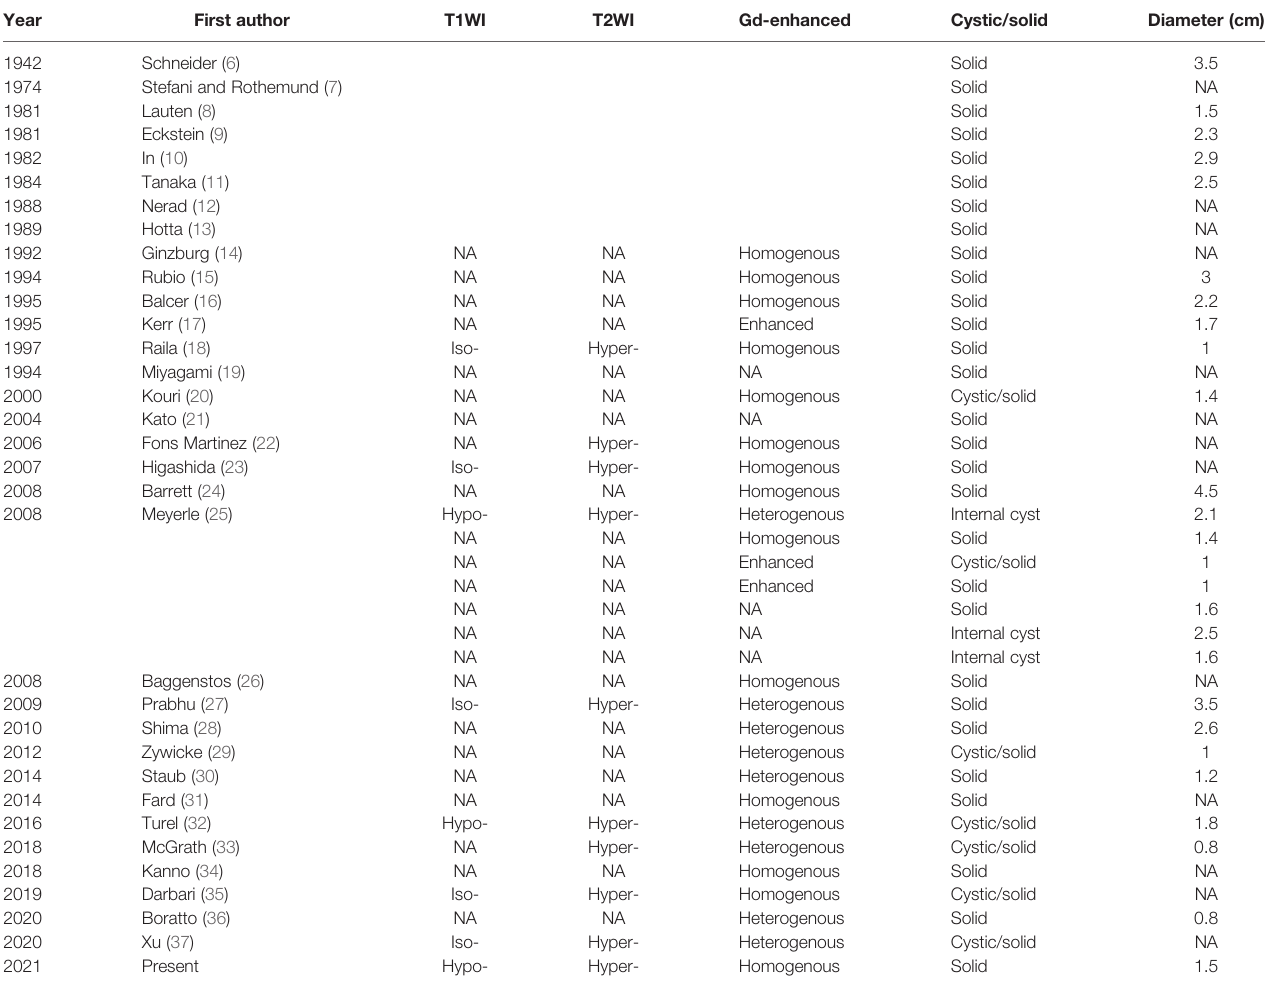
TABLE 1 | MRI fi ndings of 40 published optic nerve hemangioblastoma